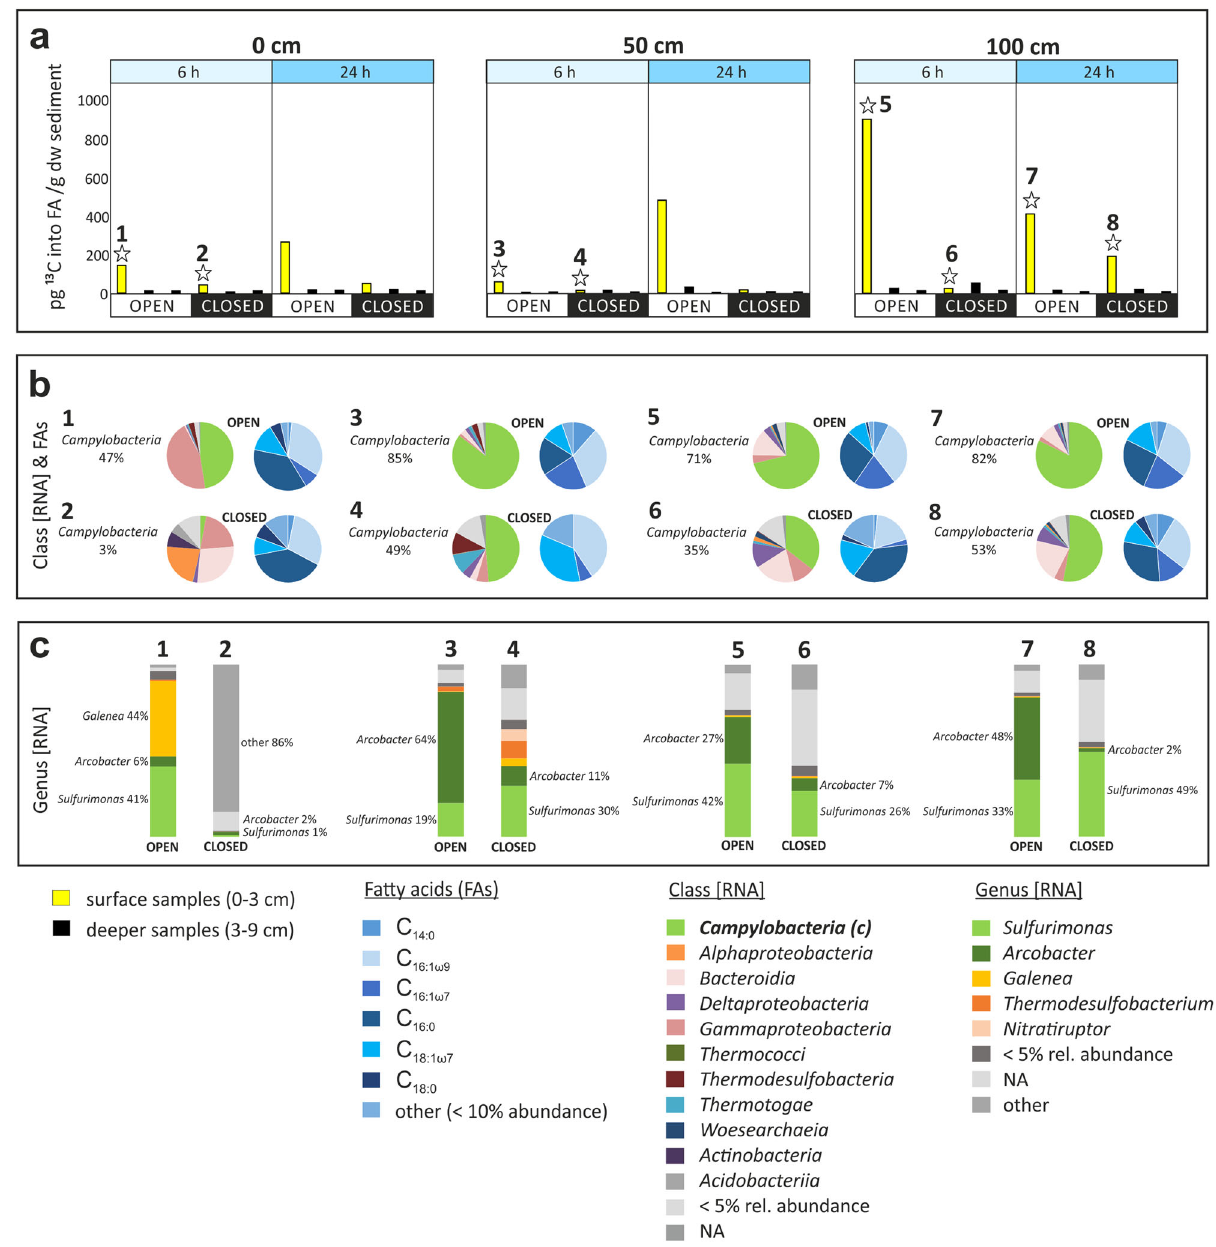
Fig. 2 Results of in situ experiments along the transect at 0, 50, and 100 cm. a Chemosynthetic production of biomass carbon based on total label uptake into all fatty acids after 6 and 24 h in open and closed incubations; yellow bars represent surface layers, black bars deeper layers. Experiments with an asterisk are detailed in panels b and c . b Microbial diversity at the class level (>5% relative abundance) based on 16 S rRNA (RNA) (colored pie charts; classes present at a relative abundance <5% were combined) and uptake into fatty acids (blue-toned pie charts) during open (1, 3, 5, 7) and closed (2, 4, 6, 8) incubations. For isotope label uptake in fatty acids during additional experiments (0_Open/Closed_24; 50_Open/Closed_24) please refer to Supplementary Table 2a, b. c Chemoautotrophic genera were identi fi ed based on 16 S rRNA (RNA) and at a relative abundance of >5%. Chemoautotrophic genera present at a relative abundance of <5% were combined. Genera not identi fi ed as chemoautotrophs were combined as “ other ” . NA not